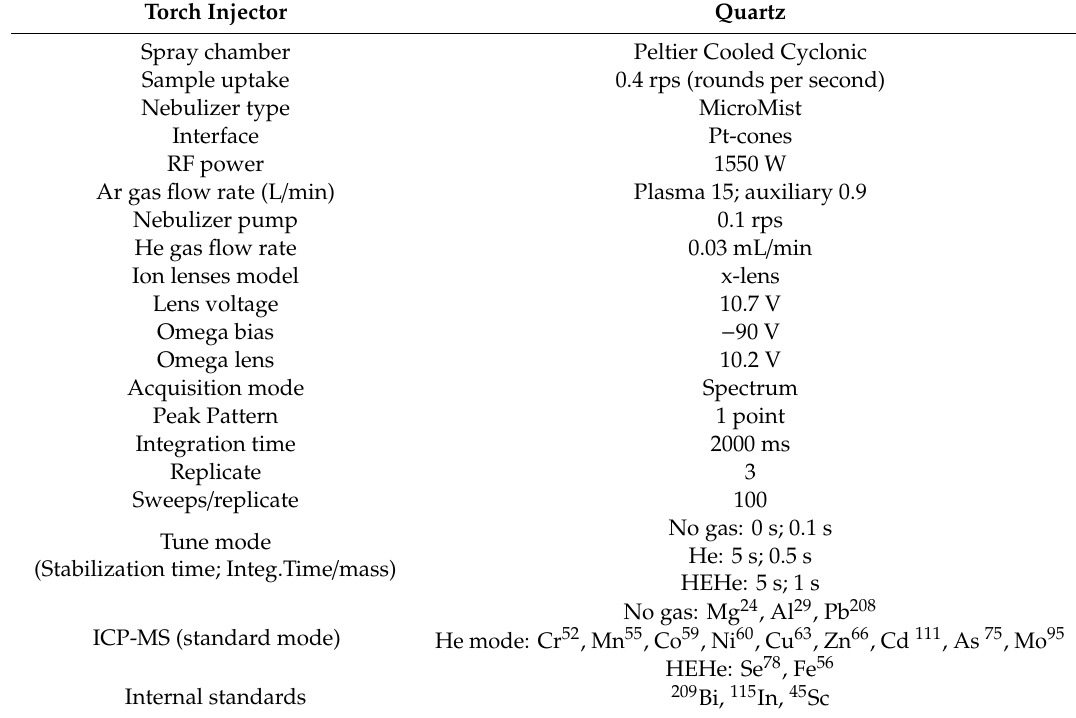
Table 1. ICP-MS operating conditions and measurement